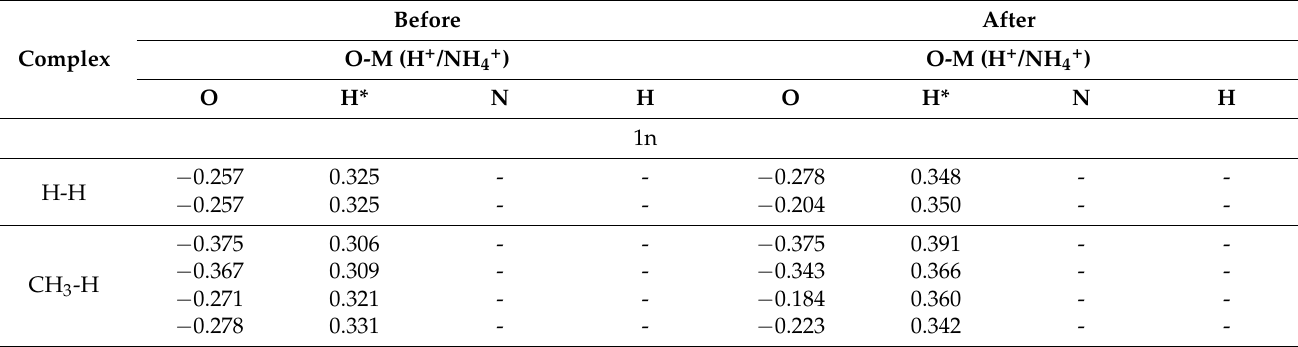
Table 5. The Mulliken charges of the M + and H + of the carboxylic groups of all